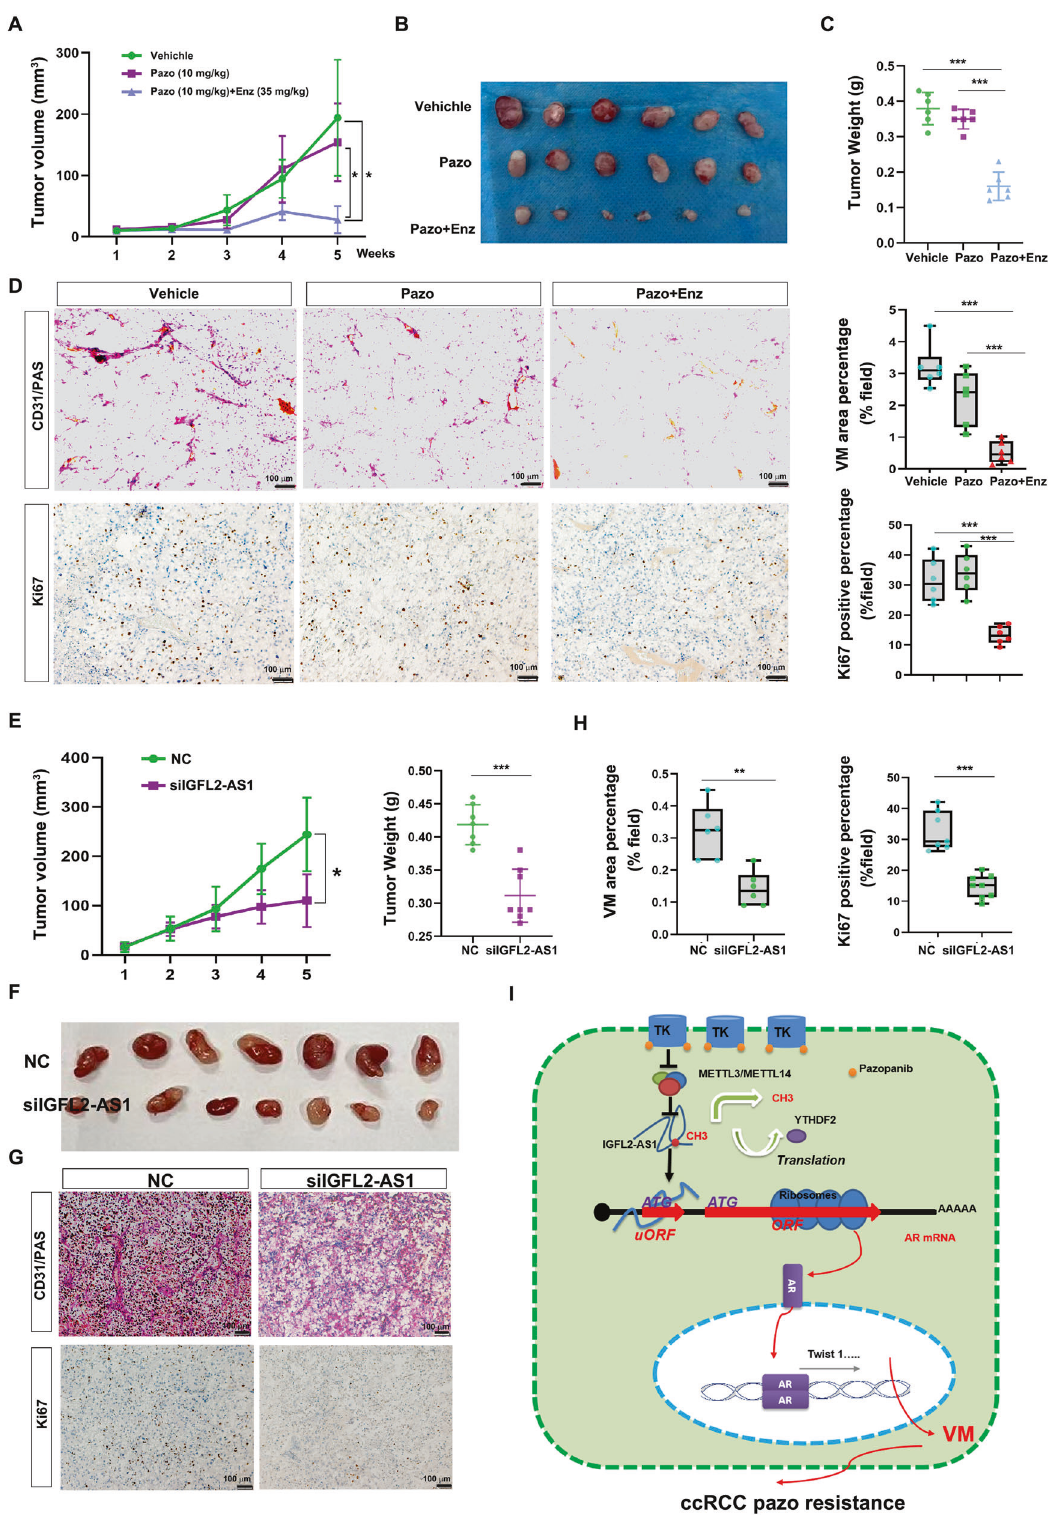
Fig. 7 Preclinically targeting AR with enzalutamide or IGFL2-AS1 with siRNAs to suppress pazopanib resistant ccRCC progression. A . Tumor growth curve of pazopanib resistant OSRC-2 tumors which received indicated therapies. 10mg/kg pazopanib and 35mg/kg enzalutamide were intraperitoneally injected every other day. B Tumor images from sacri fi ced mice in A . C Tumor weight from sacri fi ced mice in A . D CD31/PAS and Ki67 staining assays of indicated tumor sections. Left, representative images. Right, statistical analyses. Scale bar: 100 μ m. E Tumor growth curve (left) and tumor weight (right) of pazopanib resistant OSRC-2 tumors which received siNC (8 mg/kg) or siIGFL2-AS1 (8 mg/ kg) administration. F Tumor images from sacri fi ced mice which received siNC or siIGFL2-AS1 administration. G CD31/PAS and Ki67 staining assays of siNC or siIGFL2-AS1 treated tumor sections. Scale bar: 100 μ m. H statistical analyses of CD31/PAS and Ki67 staining assays in G . I Schematic depiction of how m 6 A mediated IGFL2-AS1/AR axis controls VM development and pazopanib resistance in ccRCC. * P < 0.05; ** P <0.01; *** P <0.001. Cell Death Discovery (2023)